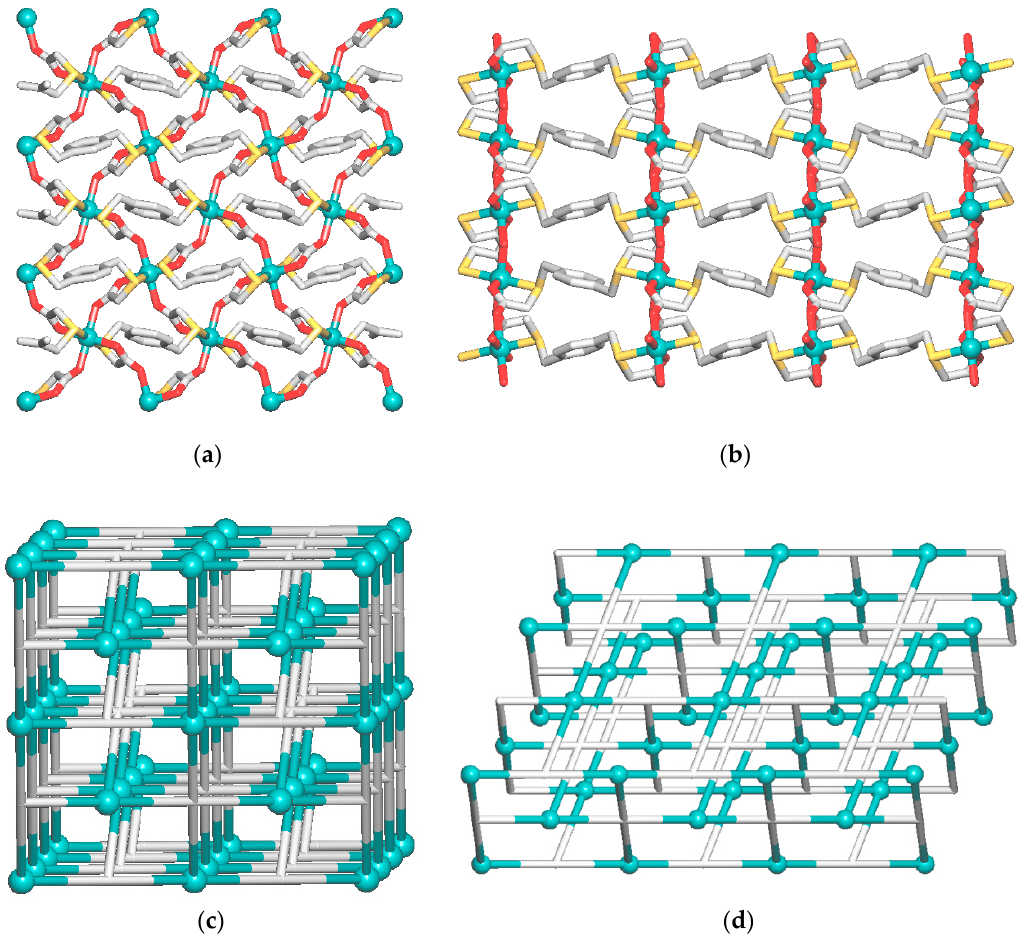
Figure 3. Structural and topological representations of polymeric metal-organic networks in 1H . ( a , b ) 3D coordination polymer structure seen along the a ( a ) and c ( b ) axis; H atoms are omitted; Zn (turquoise balls), O (red), S (yellow), C (gray). ( c , d ) Perspective topological views of a simplified 3D network displaying a uninodal 4-connected net with a cds (CdSO 4 ) topology. Rotated views along the a ( c ) and c ( d ) axis; color codes: 4-connected Zn nodes (turquoise balls), centroids of 4-connected µ 4 - p -XBT 2 ⁻ nodes (gray).